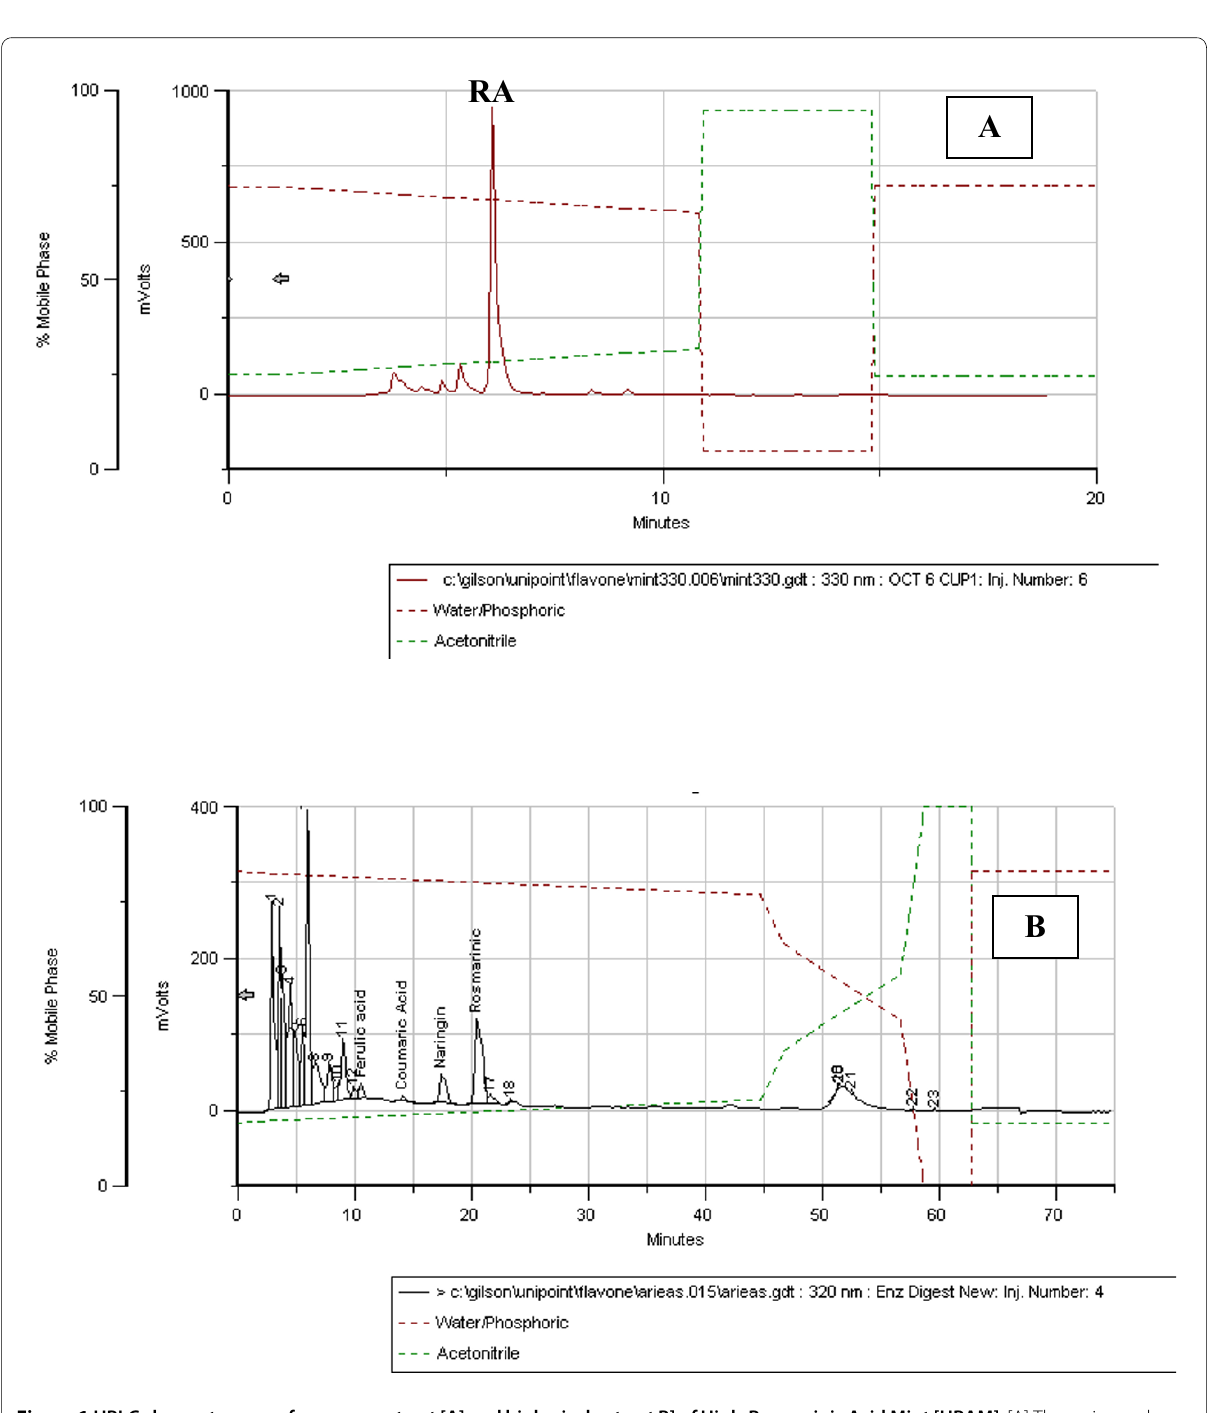
Figure 1 HPLC chromatogram of aqueous extract [A] and biological extract B] of High-Rosmarinic Acid Mint [HRAM] . [A] The major peak rep- resents rosmarinic acid [RA] at a concentration of 130 ug/mL. [B] Retention times of compounds of interest: Caffeic acid = 6.00 min; Ferulic acid = 10.52 min; m-Coumaric acid = 14.10 min; Rosmarinic acid = 20.50